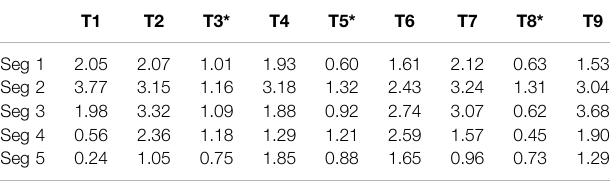
TABLE 2 | Bulk TNR distribution of nine sets of data.